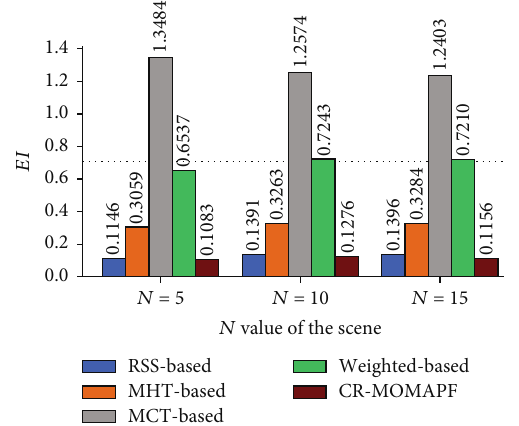
Figure 12: EI values of solutions under di ff erent